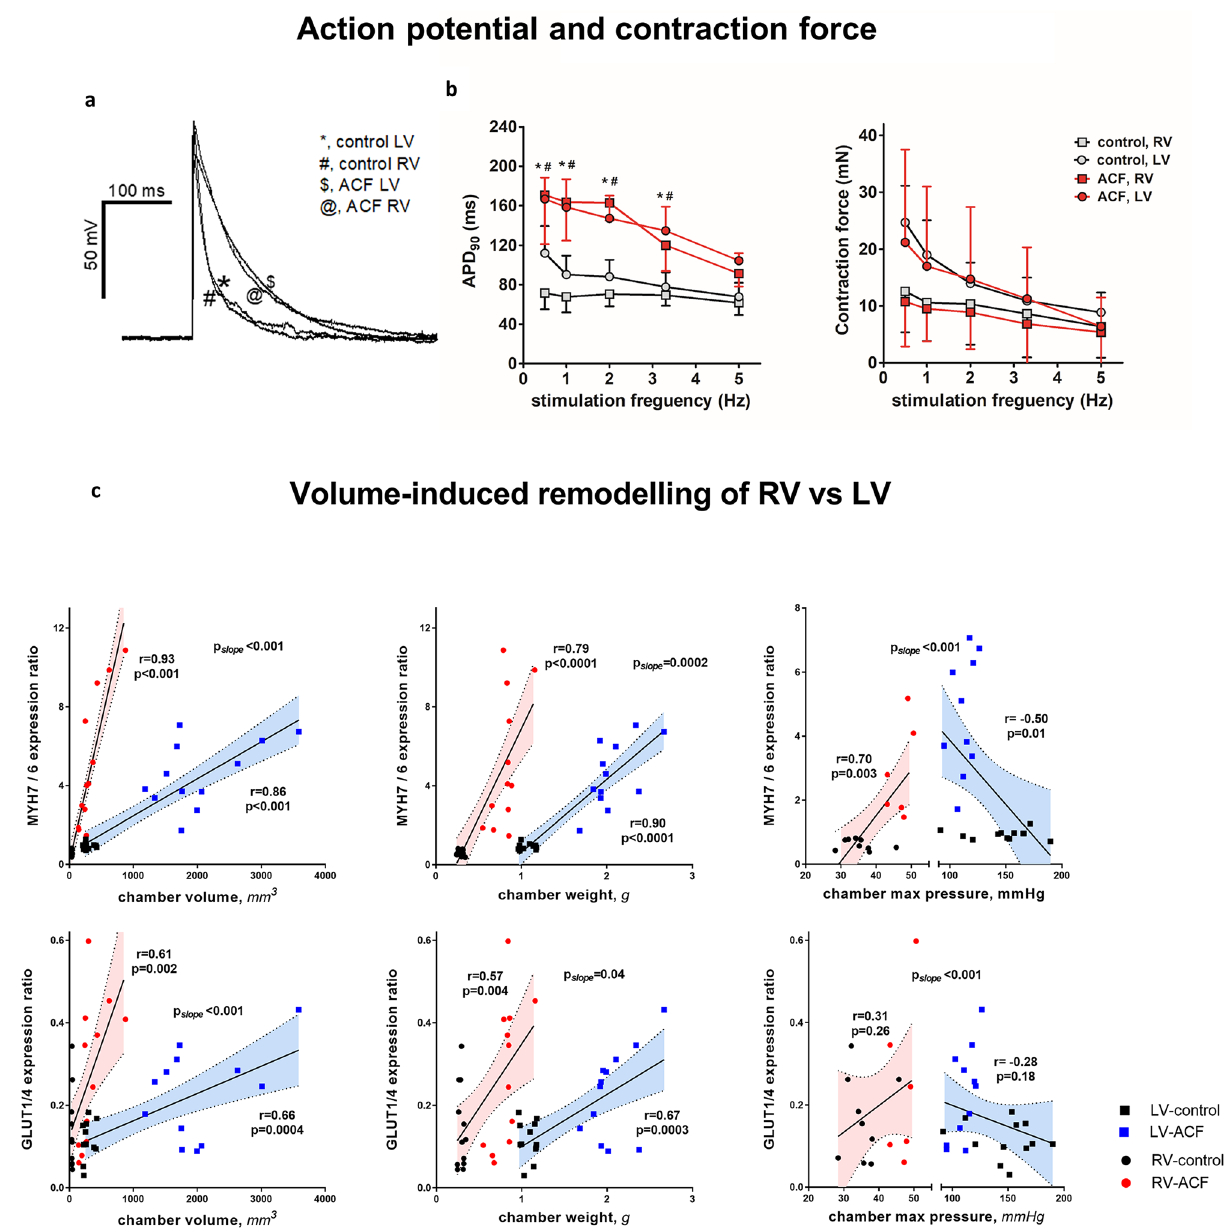
Figure 3. Biventricular differences in contraction force, action potential duration and mRNA expression regulation in volume overload from aorto-caval fistula (ACF). ( a ) Example of action potential recording from isolated papillary muscle. ( b left ) Action potential duration at 90% repolarization (APD90) in RV and LV papillary muscles in controls and in ACF rats. Measurements at stimulation frequencies of 0.5, 1, 2, 3.3 and 5 Hz. *, p < 0.05, RV control vs. RV ACF; #, p < 0.05, LV control vs. LV ACF (3-way ANOVA). ( b right ) Maximal contraction force in RV and LV papillary muscles in control and ACF rats. ( c ) Relation of hypertrophy determinants to gene mRNA expression patterns in RV and LV. Note discordant relations between gene expression and ventricular pressures; concordant but steeper relation of RV compared to LV. r: Pearson´s correlation coefficient, p: p -value of correlation. The line represents linear regression with 95% confidence bands. p slope denotes the difference between regression